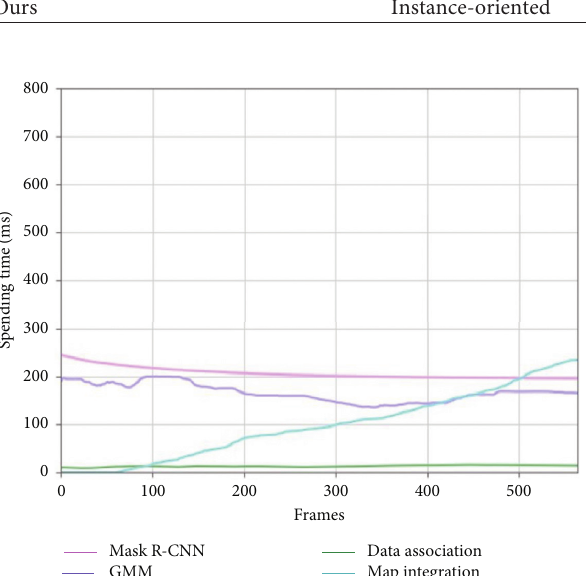
Figure 3: Measured execution times of each stage of the proposed incremental instance-oriented mapping system, averaged over the 5 evaluated sequences from the SceneNN